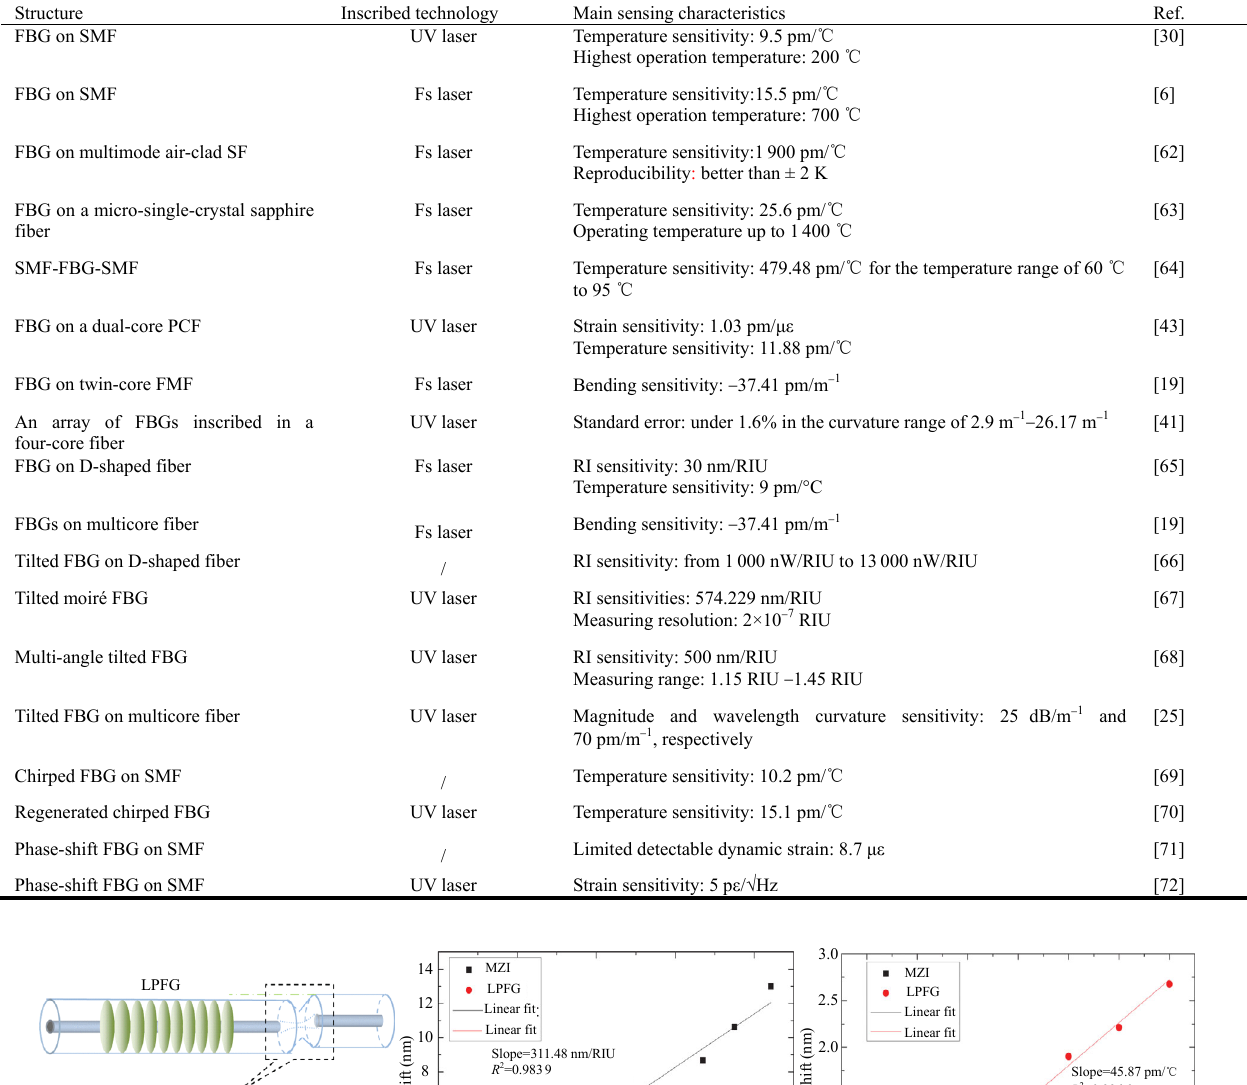
Table 3 Sensing characteristics comparison of different FBG-based FOM sensors. Structure